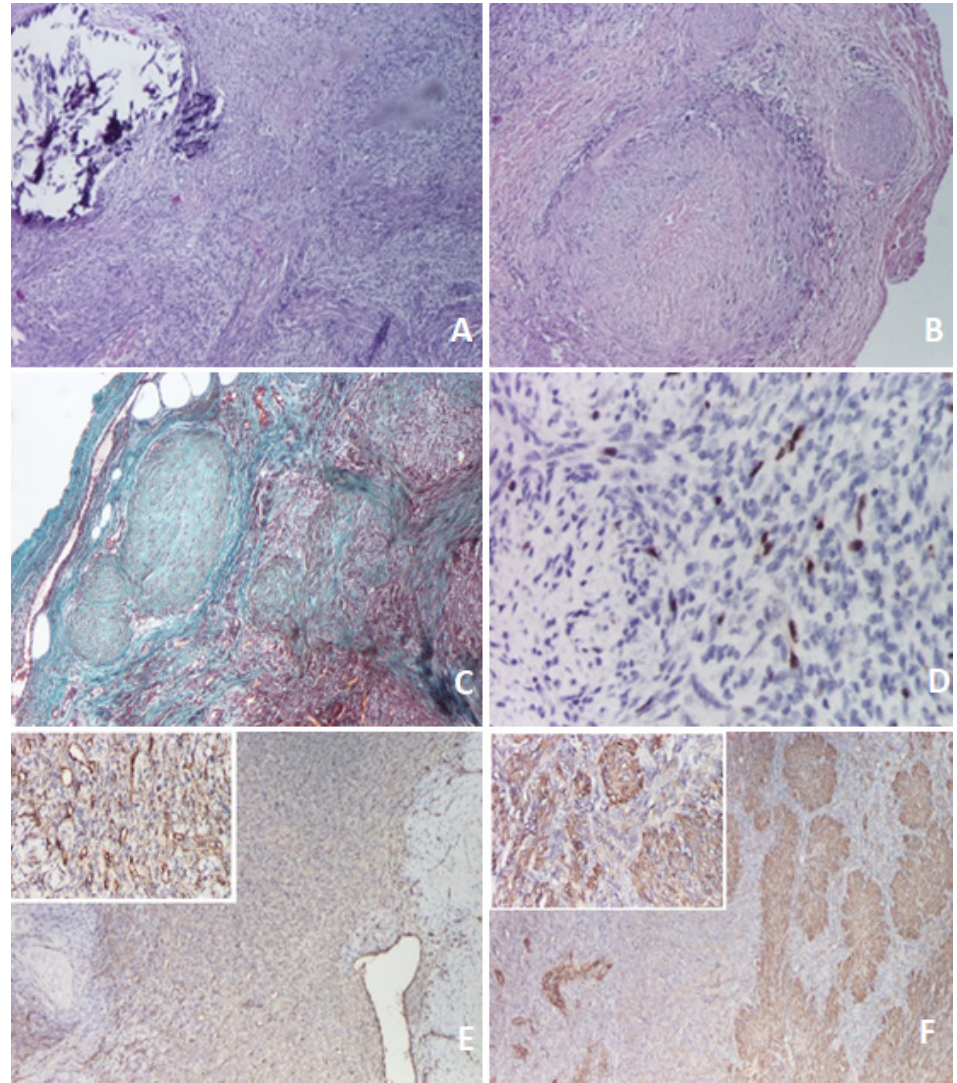
Figure 4. Hemathoxilin eosine staining (×40): ( A ) Multiple fusiform cells, arranged in fascicle and nodules. ( B ) Node with central necrosis. Trichromic Szekely stain (×40): ( C ) Biphasic aspect. Immunochemistry: ( D ) Ki67 + in about 5% of the tumor (×200). ( E ) CD34—vascular hemangiopericytoma-like proliferation (×40/×200). ( F ) Smooth muscle actin stain miotic nodule (×40/×200).